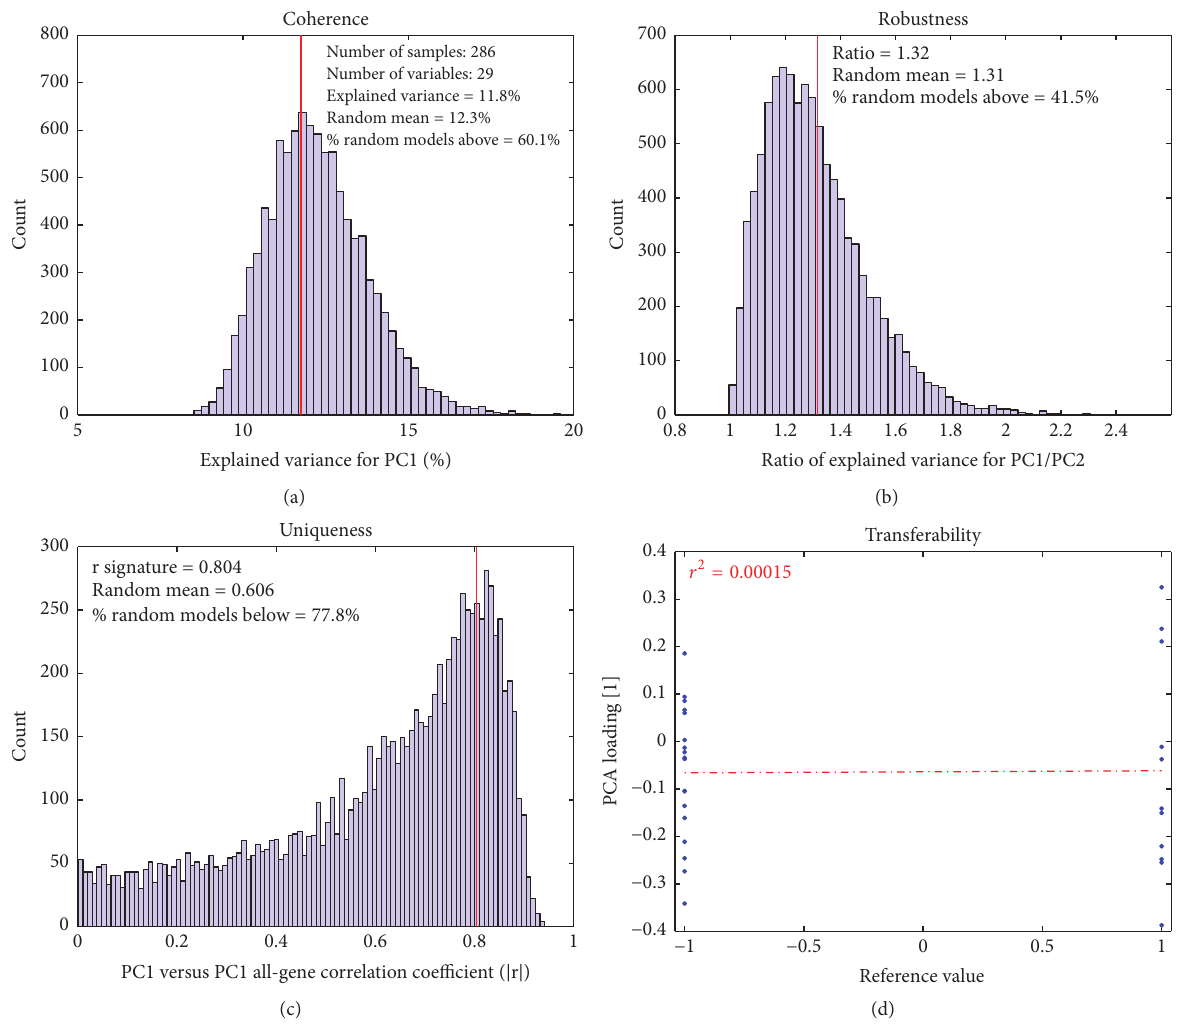
Figure 3: Validation plot for Gender-29 signature applied to Breast dataset. The probesets within the Gender-29 signature are no longer coherent (a), and the ratio of PC1/PC2 is much lower (b). It is also clear that the signature is no longer unique (c). Finally, the biological meaning of the probesets has changed in the Breast dataset